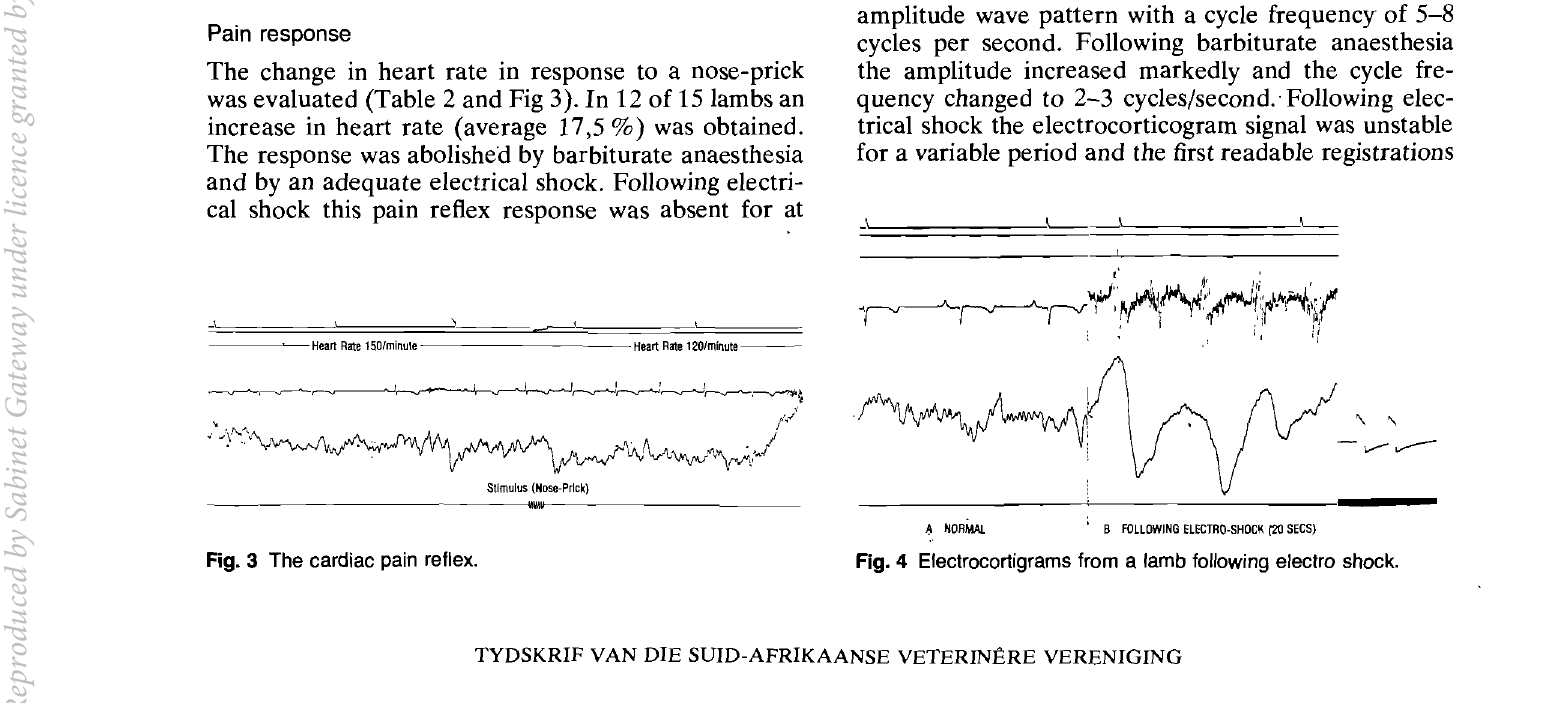
Fig. 4 Electrocortigrams from a lamb following electro